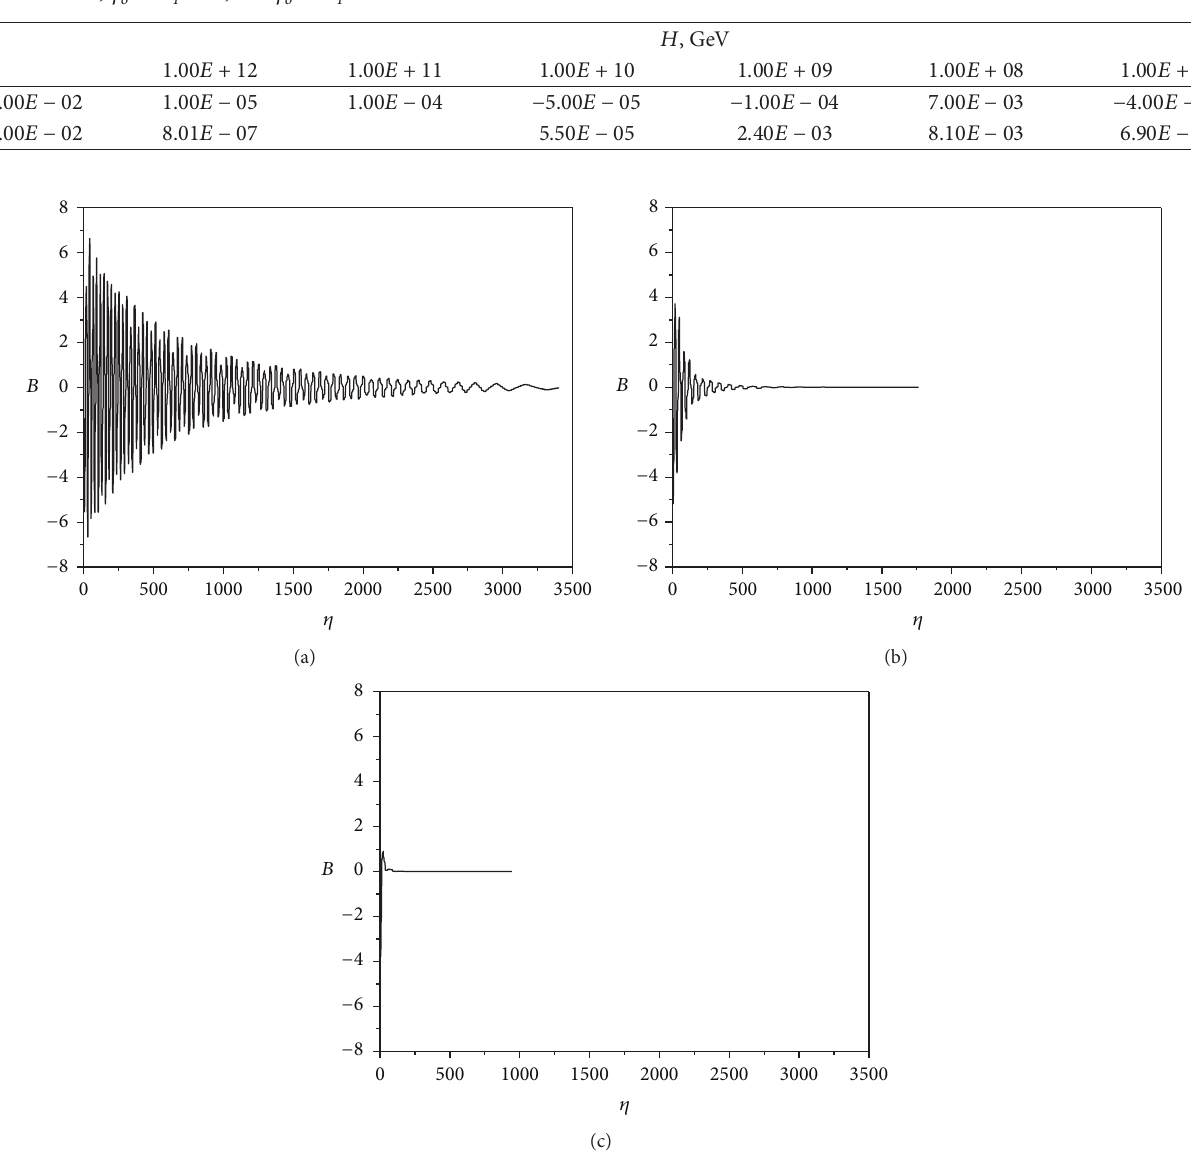
Figure 2: The evolution of the baryon charge 𝐵(𝜂) for 𝜆 1 = 5 × 10 −2 , 𝜆 2 = 𝜆 3 = 10 −3 , 𝐻 = 10 10 GeV, 𝑚 = 350 GeV, 𝜑 𝑜 = 𝐻 𝐼 𝜆 −1/4 , and ̇𝜑 = 𝐻 𝐼2 . (a) For 𝛼 = 10 −3 , (b) for 𝛼 = 10 −2 , and (c) for 𝛼 = 5 × 10 −2 𝑜